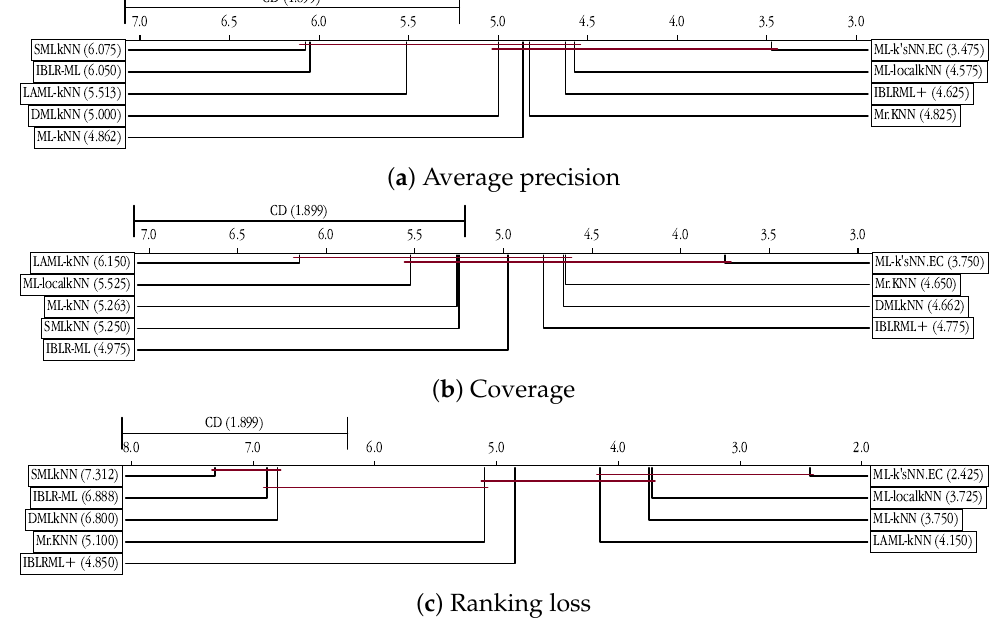
Figure 9. Nemenyi test for the different variants of ML-kNN and the different ranking